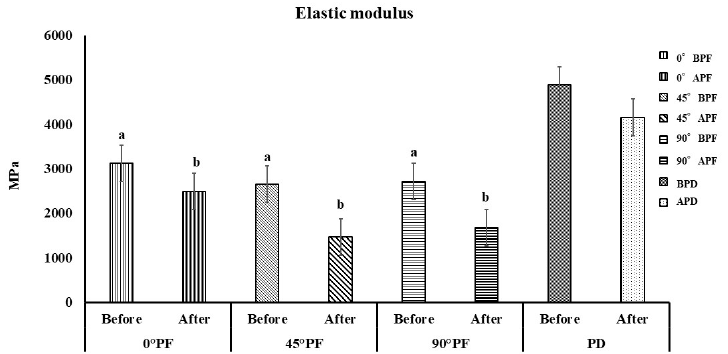
Figure 3. Elastic modulus in 3-point bending tests ( p < 0.05, I: 95% con fi dence interval standard deviation); there is no statistically signi fi cant di ff erence between results indicated by “a” or by “b”.